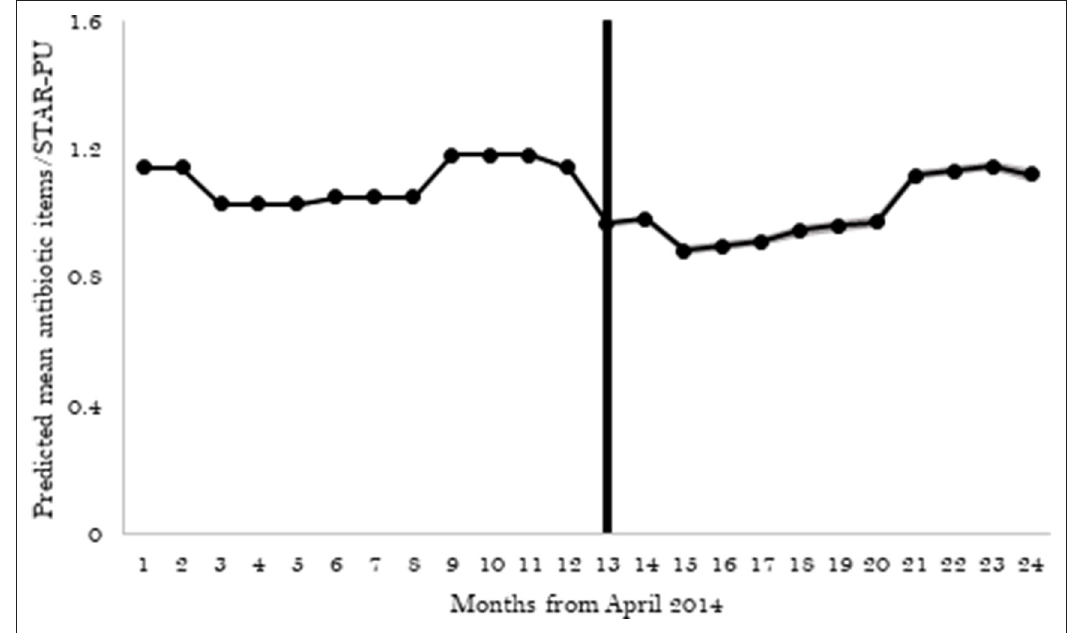
Figure 1 Effect of QP on antibiotic prescribing. The shaded portion around the line represents the 95% CI. The vertical line indicates implementation of the 2015–2016 QP in April 2015. STAR- PU = specific therapeutic group age–sex related prescribing